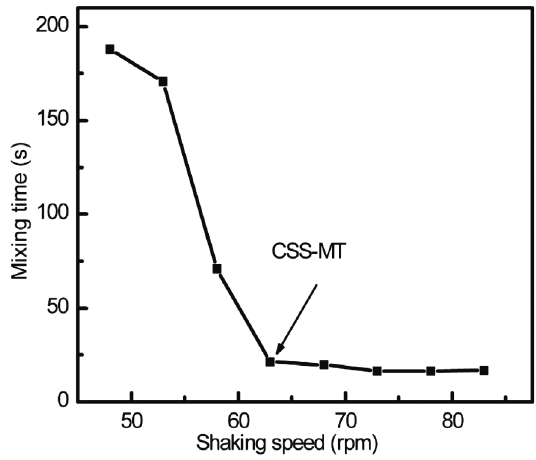
Fig. 6: A typical definition of CSS-MT